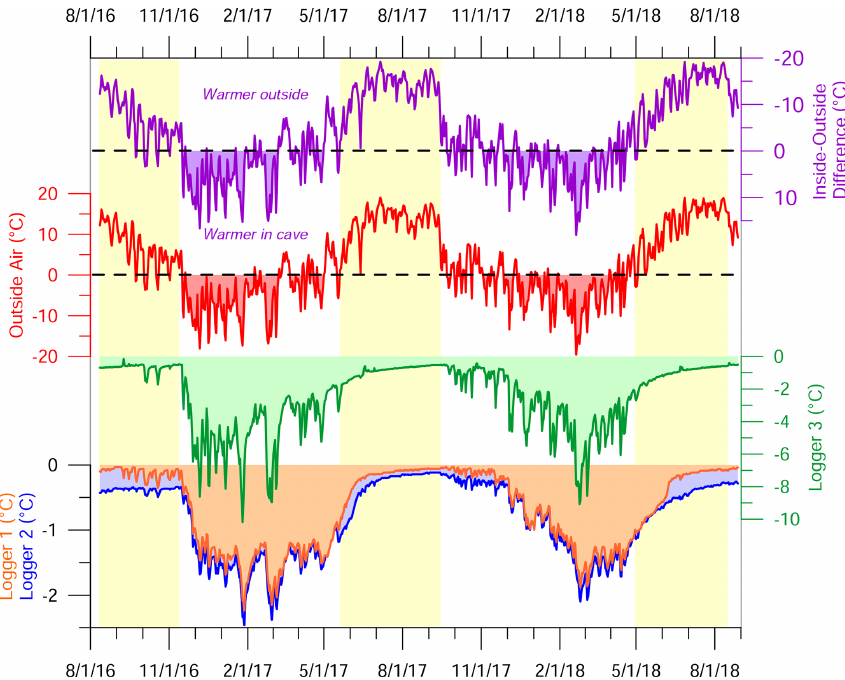
Figure 3. Temperature records from data loggers deployed in Winter Wonderland Cave from August 2016 through August 2018. Logger 1 was at the Skating Rink, Logger 2 along the Frozen Freeway, and Logger 3 in the Icicle Room (Fig. 1c). Outside air temperature was recorded by a logger in a solar-radiation shield outside the cave entrance. Yellow shading highlights the summer periods, when cave ventilation is greatly reduced. The purple time series at the top displays the difference between the temperature at Logger 1 and the temperature outside the cave; note the inverted axis. Time series from loggers within the cave are filled below 0 ◦ C. Dashed black lines highlight 0 ◦ C on the outside air and the temperature difference